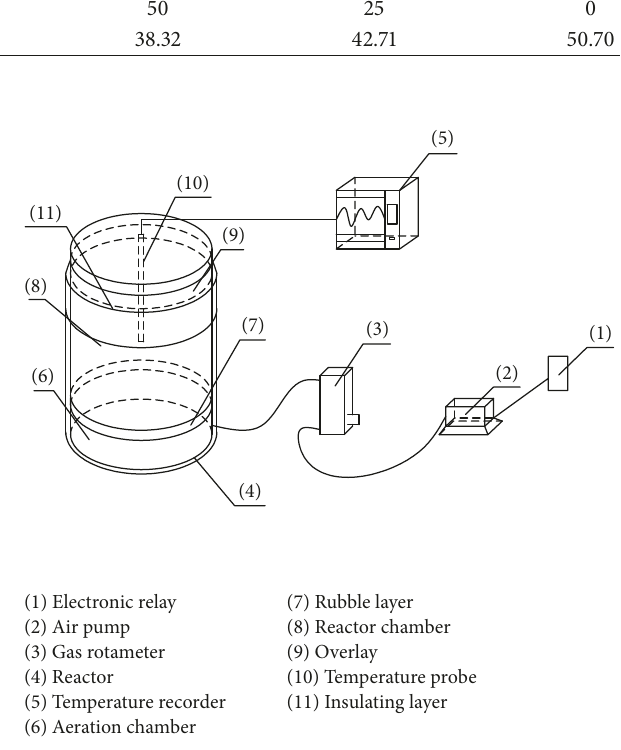
Figure 1: Experimental